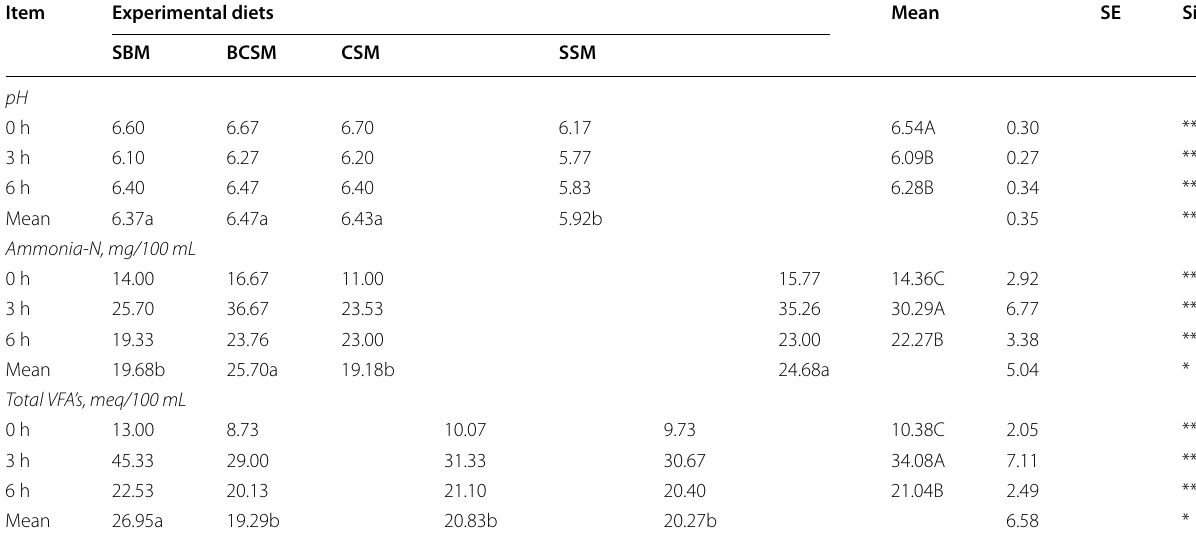
a and b: Means in the same row with different superscripts between treatments are significantly different. A, B and C: Means in the same columns with different superscripts between times are significantly different. SE, standard error; NS, *: Significant difference at ( p < 0.05). **: Significant difference at ( p <